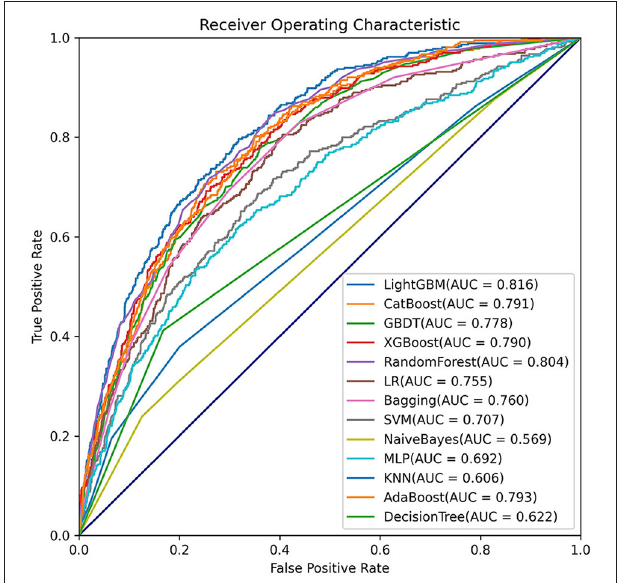
FIGURE 7 | Comparisons of different machine learning models in external validation